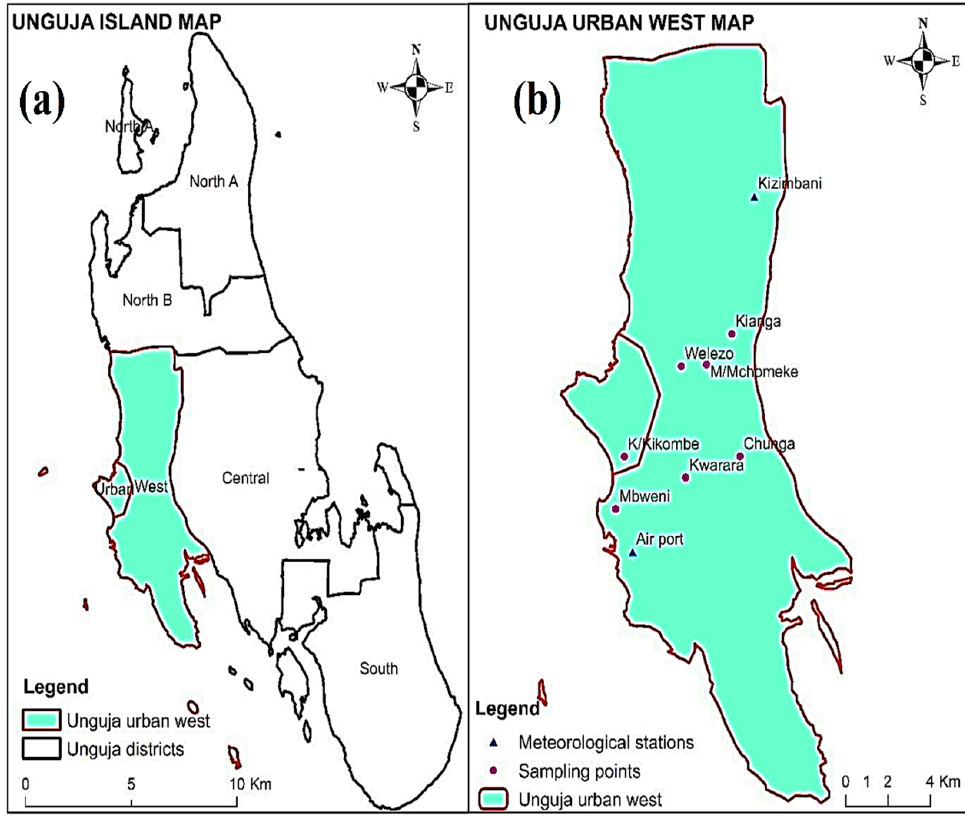
Figure 1. A map of the island of Zanzibar (Unguja) indicating different regions ( a ) and wards of the Urban West region ( b ) where the original sampling took place. Used with permission from Ali and Rwiza [31].